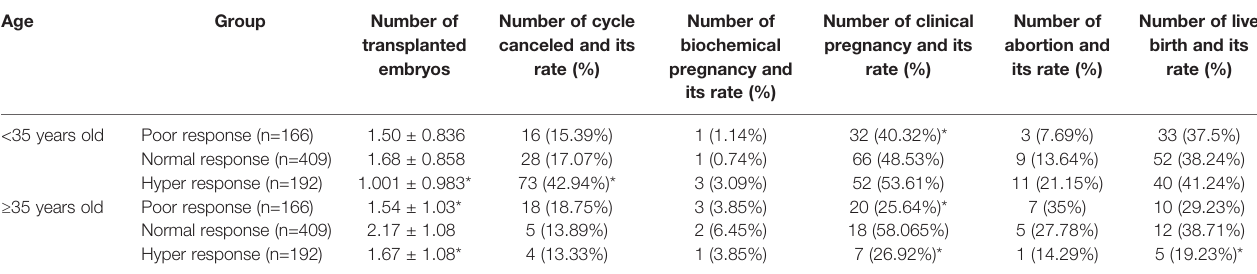
TABLE 3 | Clinical outcomes of different ovarian response groups.